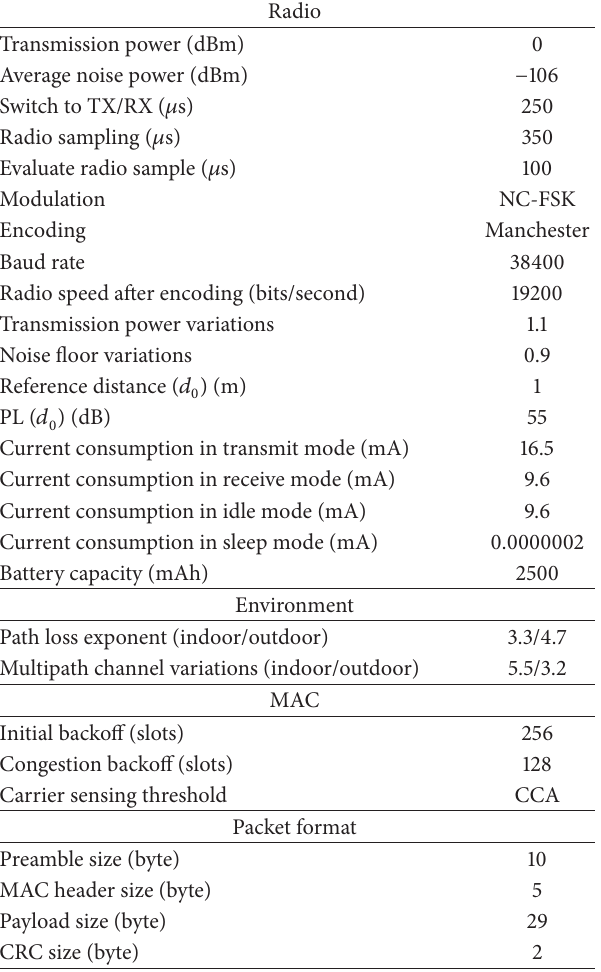
Table 1: Simulation